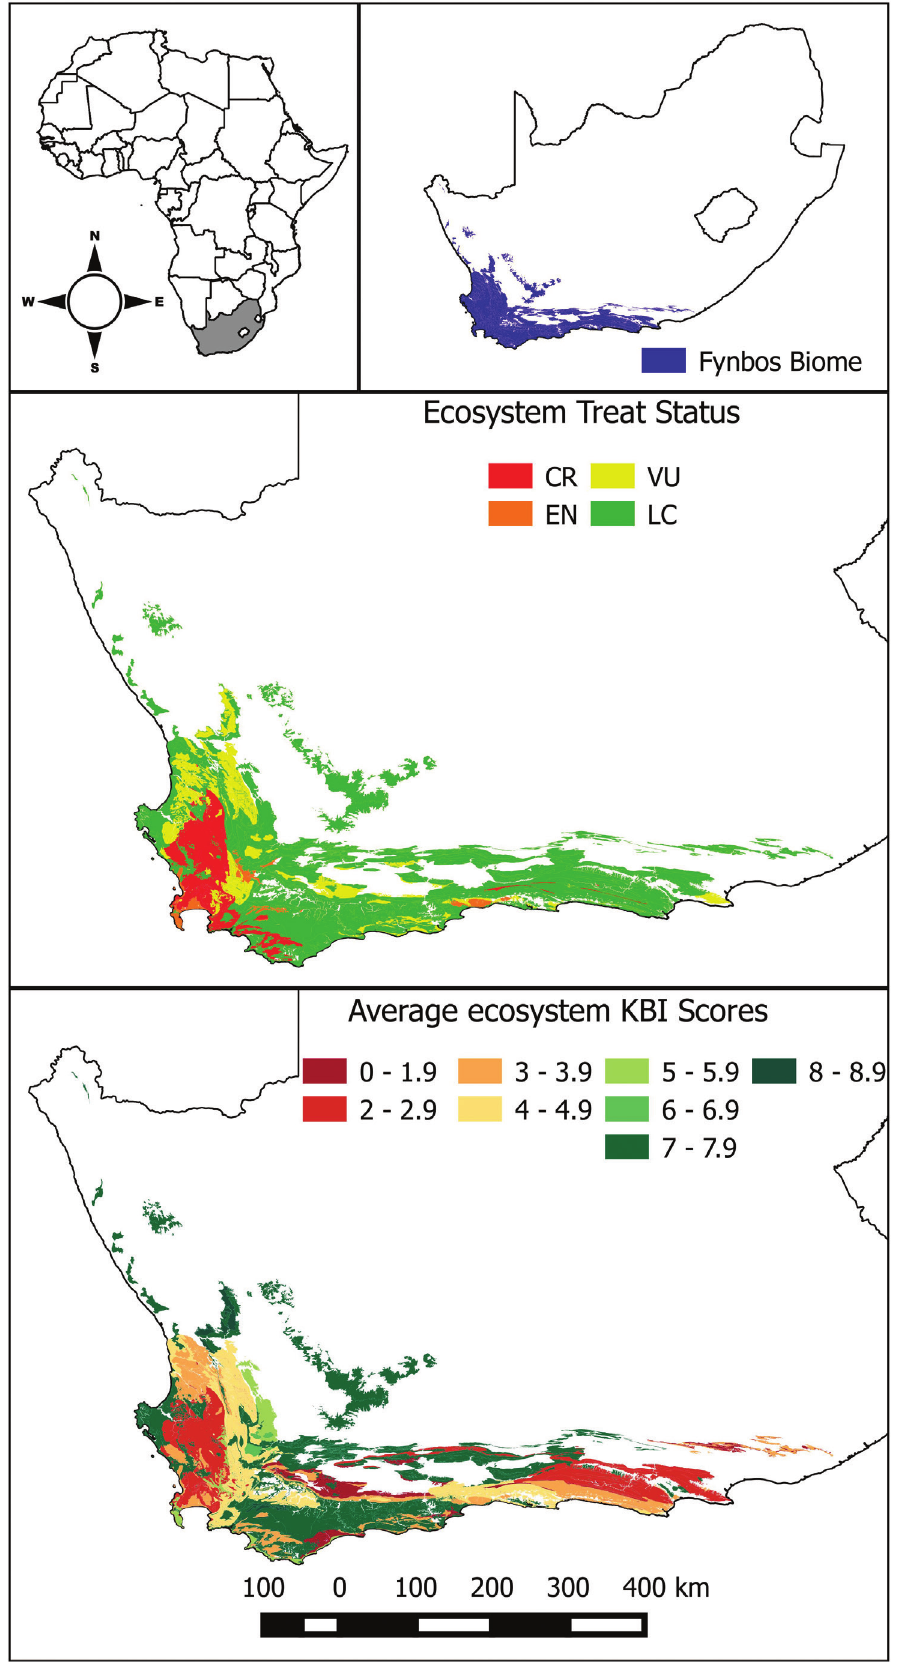
Figure 5. Map of ecosystem threat statuses and the average KBI scores (i.e. KBI/Site) of each